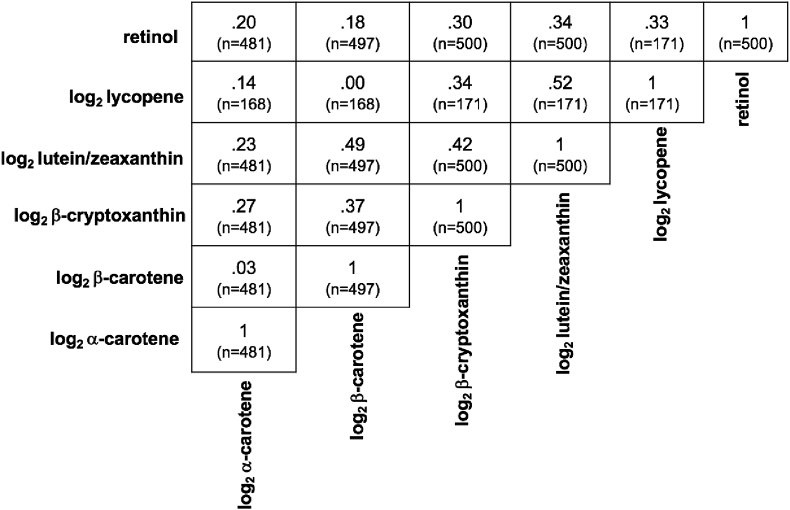
Correlations between plasma carotenoids in 6–8 year old children of rural Nepal. Correlation coefficients were generated using all complete pairwise data. All of the correlations were statistically significant (p < 0.0001) except log2 β-carotene with log2 α-carotene (p = 0.56), log2 β-carotene with log2 lycopene (p = 0.96) and log2 α-carotene with log2 lycopene (p = 0.0786).